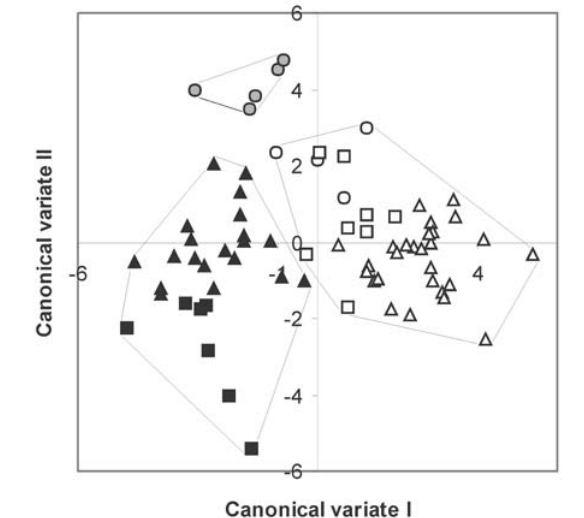
Fig. 5. Scatter diagram of scores of specimens on first and second axis of size-free Canonical Variate Analysis of Microglanis garavelloi from rio Pirapitingui (open circles), rio Capivara (open squares), rio Taquari (open triangles), M. parahybae from rio Dois Rios (solid triangles) and rio Muriaé (solid squares), and M. cottoides from Sanga das Águas Frias (solid